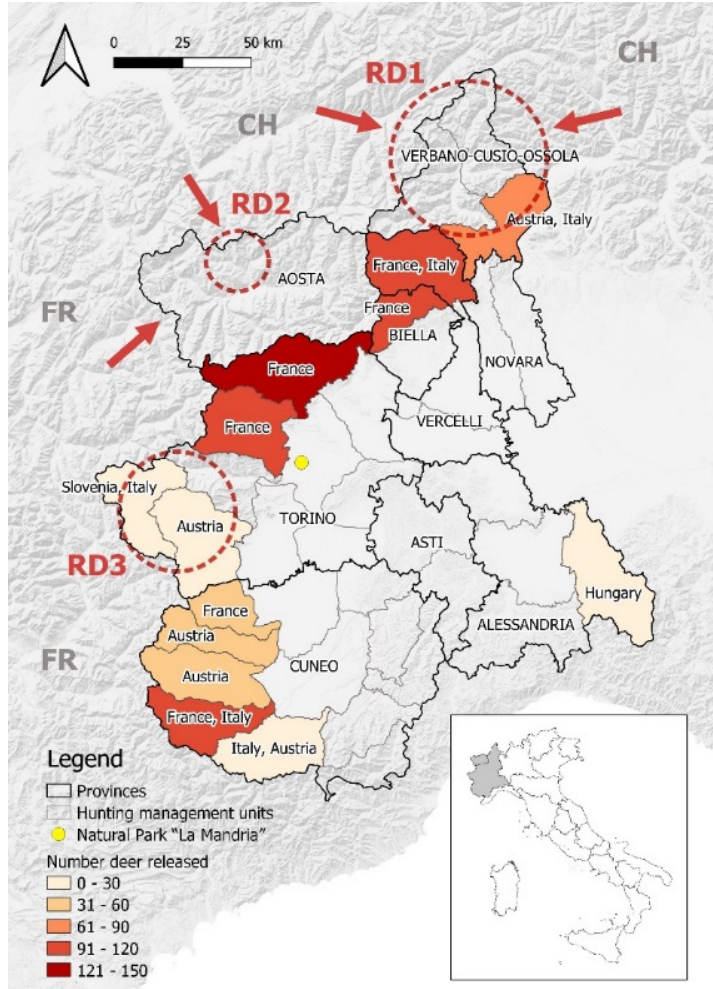
Figure 1. Map of NW Italy showing the hunting management units where RD were translocated between 1962 and 2005. The red circles highlight the areas under passive surveillance for macroscopic external parasites (RD1 = Ossola Valleys; RD2 = Gran S. Bernardo and Valpelline Valleys; RD3 = Susa and Chisone-Germanasca Valleys). Arrows indicate the zones that were initially recolonized by RD migrated from Switzerland (CH) and France (FR). The yellow dot corresponds to the Natural Park of La Mandria. Names of the country in the colored areas represent the origin country of the RD population. Borders of provinces adapted from: Regione Piemonte—A1613B—